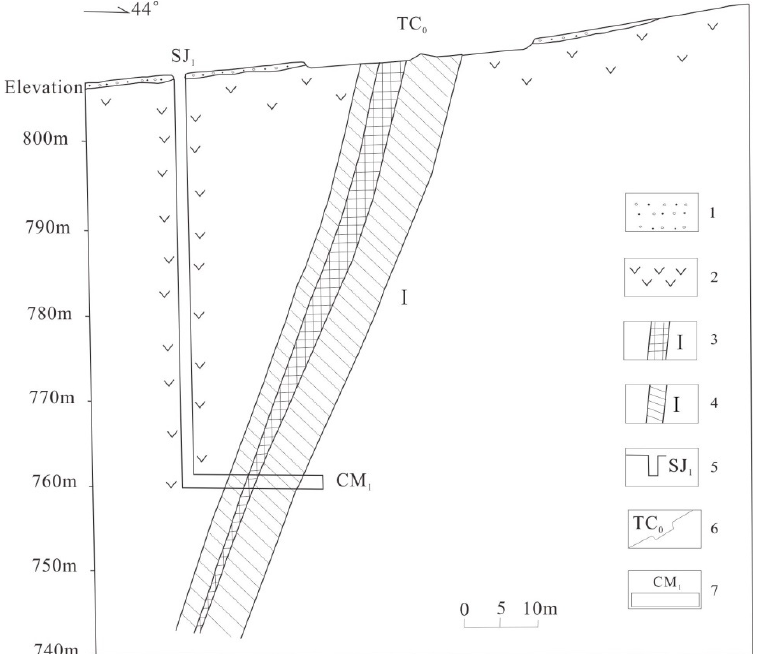
Figure 3. Cross-section of I orebody in No.0 exploration line [16]. 1—Quaternary alluvium deposits; 2—Andesite; 3—Orebody; 4—Alteration zone; 5—SJ 1 :shaft and its number; 6—TC 0 : exploratory trench; 7—CM 1 : footrill. Hydrothermal alteration is common in the surrounding andesites of the upper and lower walls of the ore body forming an alteration zone with a width of 1–5 m.